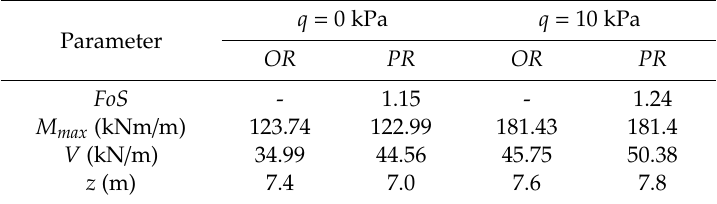
Table 8. Comparison of optimization results and numerical analysis for 6 m excavation